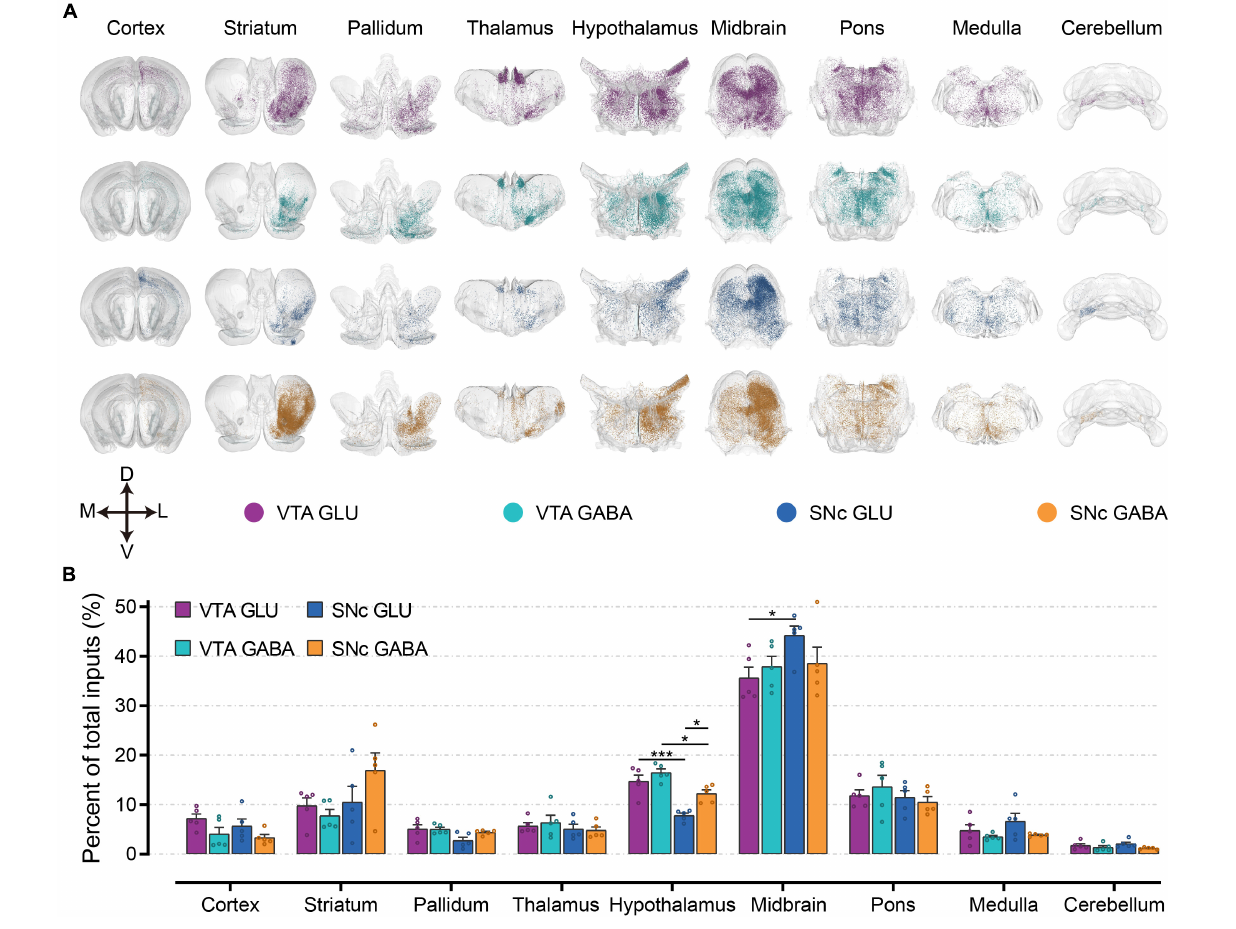
FIGURE 3 | Whole-brain monosynaptic inputs to glutamatergic and GABAergic neurons in VTA and SNc in nine brain areas. (A) 3D visualization of whole-brain monosynaptic inputs to glutamatergic and GABAergic neurons in VTA and SNc in nine brain areas. M, medial; L, lateral; D, dorsal; V, ventral. (B) Proportions of total inputs from nine brain areas. Mean ± SEM ( n = 5 mice each for the VTA GLU, VTA GABA, SNc GLU, and SNc GABA groups). *** p < 0.001 and * p < 0.05. Only significant differences between the same cell type in different brain areas or between cell types in the same brain areas are marked; one-way ANOVA followed by Tukey’s post hoc tests. The percentages of inputs in nine brain areas are listed in Supplementary Data 1